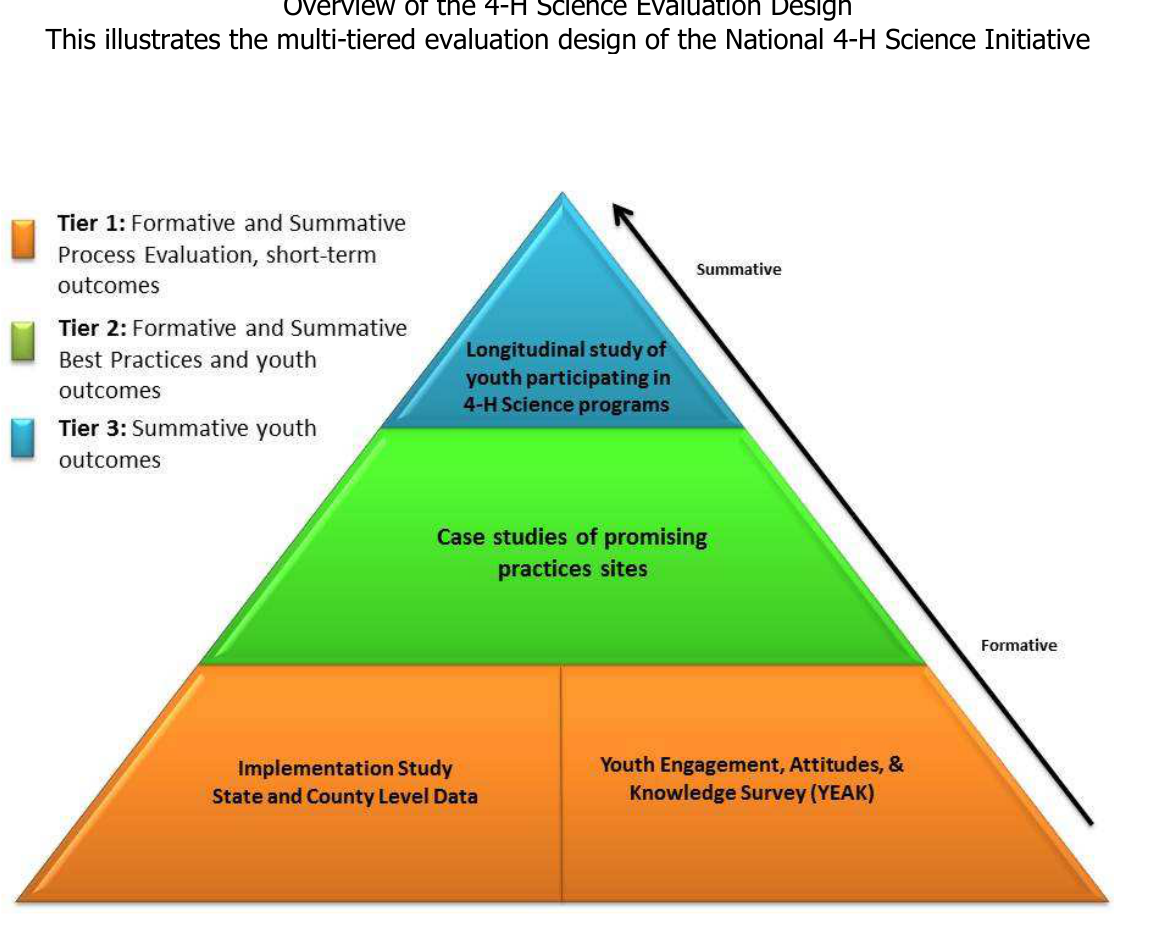
Overview of the 4-H Science Evaluation